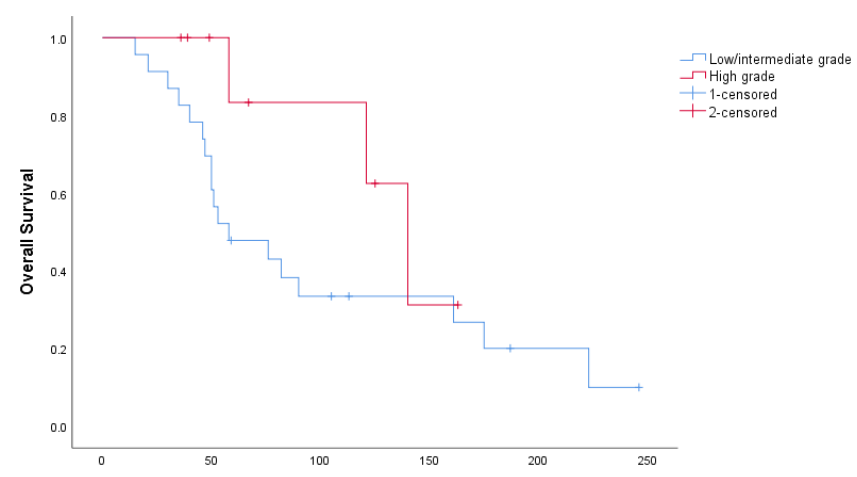
Figure 2. Overall survival, stratified by tumor grade.